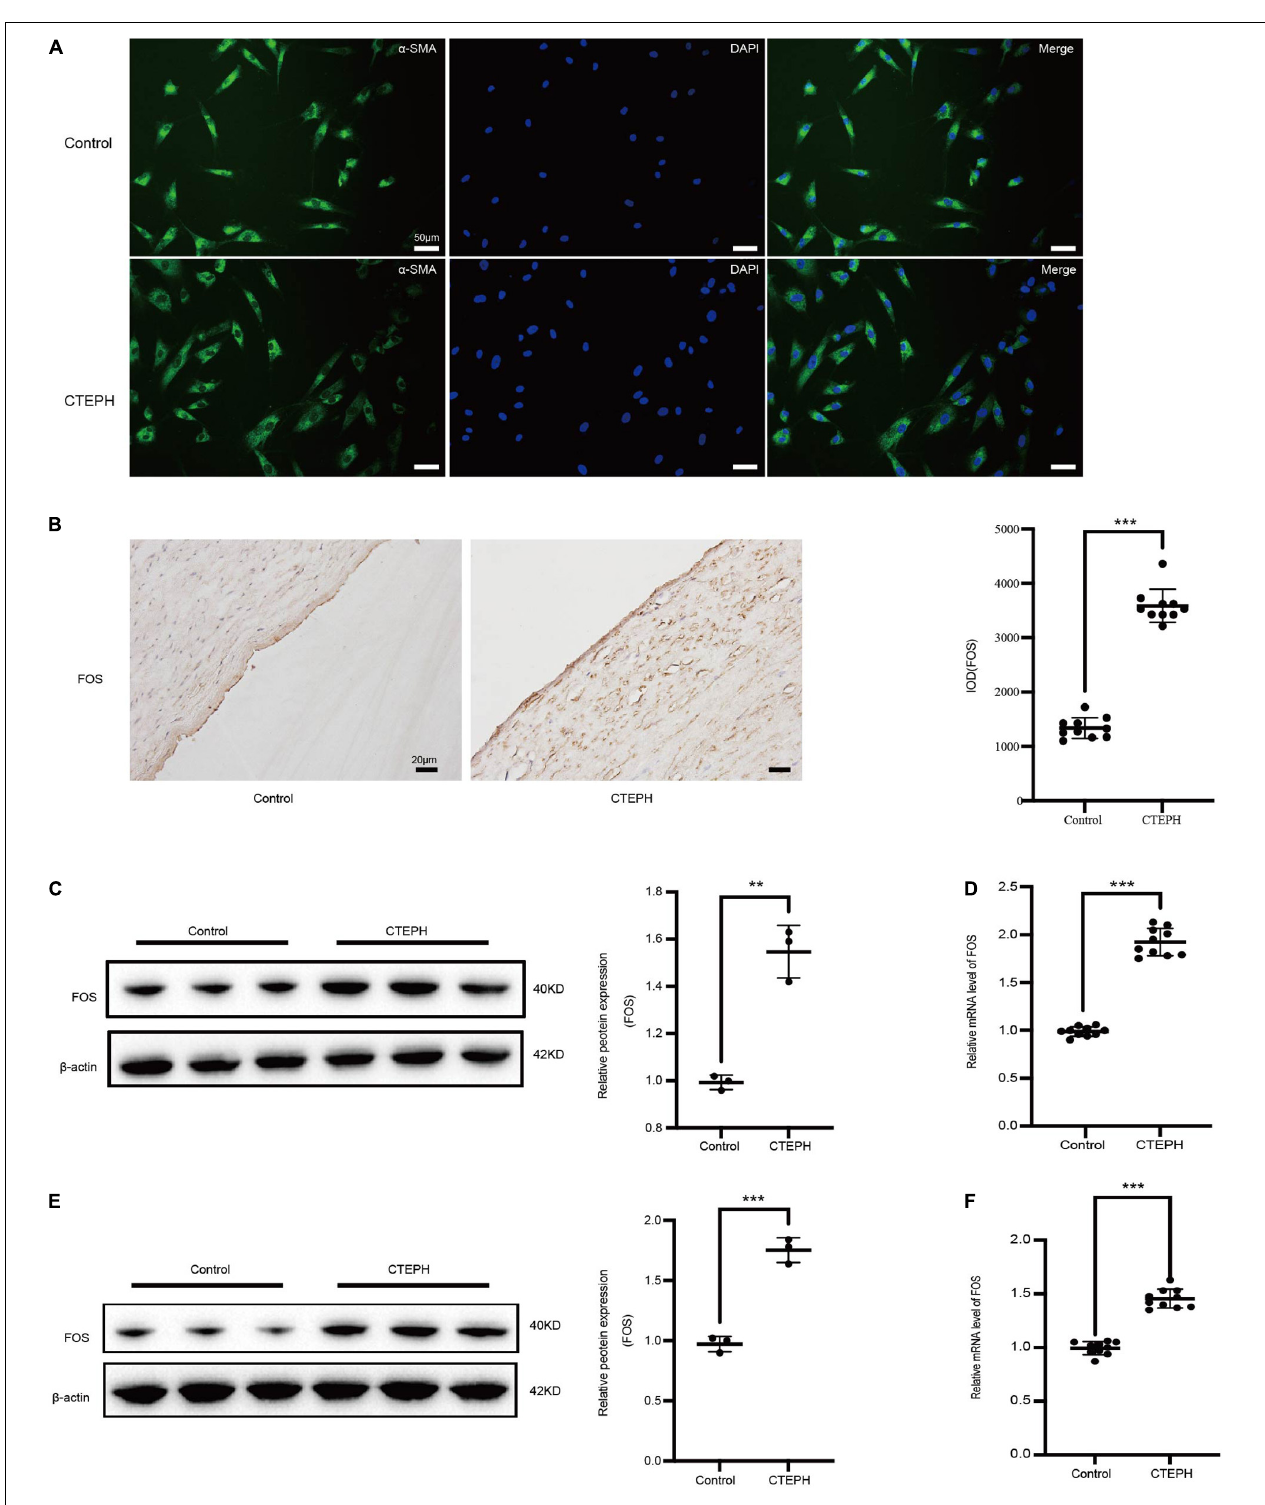
FIGURE 5 | FOS expression in vascular tissues and primarily VSMCs. (A) Identification of vascular smooth muscle cells (VSMCs) derived from patients with CTEPH and from controls. Immunocytochemistry analysis shows that the SMCs were positive for alpha smooth muscle actin ( α -SMA). (B) Representative immunostaining for FOS in control and CTEPH vascular tissue, and corresponding quantification of IOD. N = 10, results are expressed as the mean ± SD, *** p < 0.001. FOS protein (C) and mRNA (D) levels in control and CTEPH vascular tissues and their primary VSMCs (E,F) using Western blot and PCR, respectively, n = 3 or 10, results are expressed as the mean ± SD, ** p < 0.01, and *** p < 0.001. Data were analyzed using student t -test.